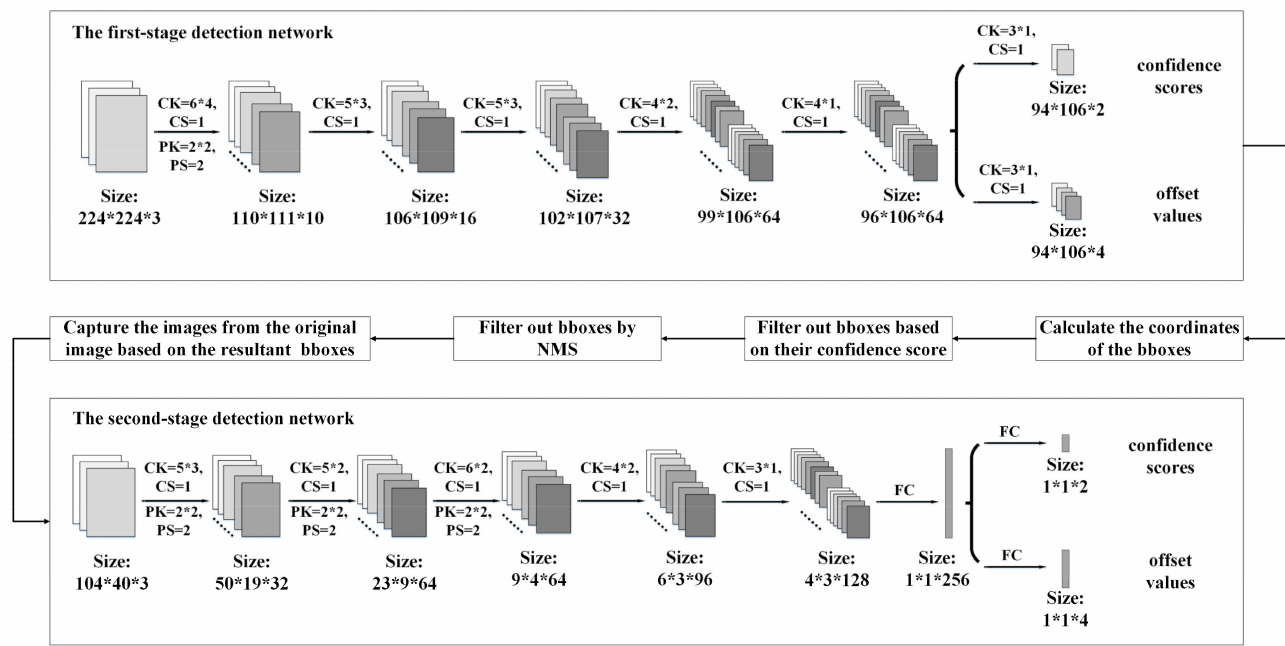
Figure 2. Proposed TLDN. The upper part is the first-stage detection network and the lower part is the second-stage detection